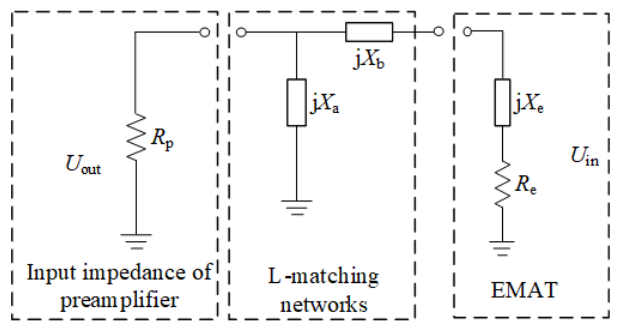
Figure 2. EMAT receiving equivalent circuit model.